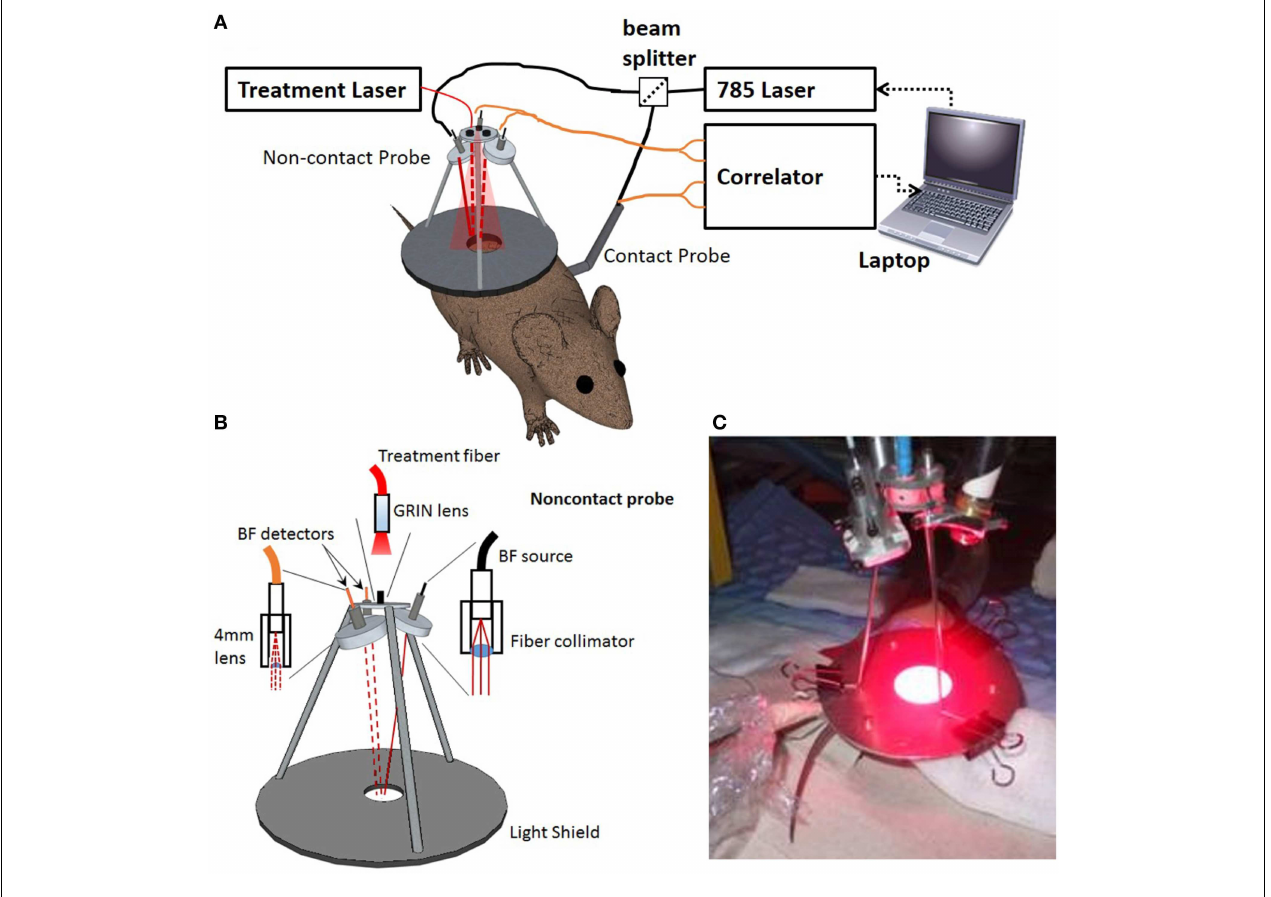
FIGURE 1 | Setup for continuous blood flow measurements during PDT. (A) Schematic showing the basics of the DCS instrument including the laptop, laser, correlator, and beam splitter along with the two probes in relation to the mouse. The contact probe was placed directly on the mouse’s